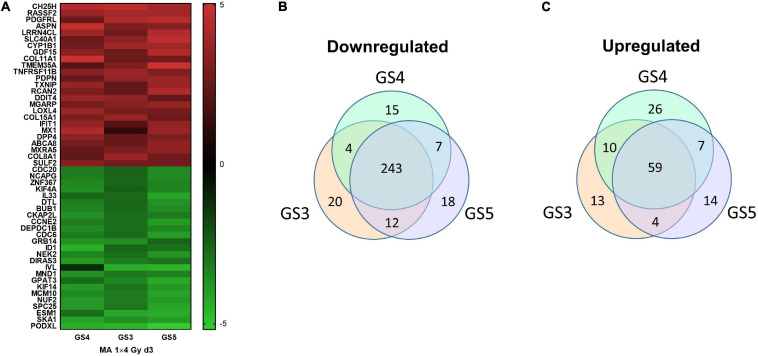
Heat map of top25 up- and downregulated genes in the three fibroblast strains (GS3-5) on day 3 in microarray experiments #3–5 (A). Venn diagrams for pathways upregulated (B) or downregulated (C) on day 3 after a single dose of 4 Gy to the three fibroblast strains GS3, GS4, and GS5.